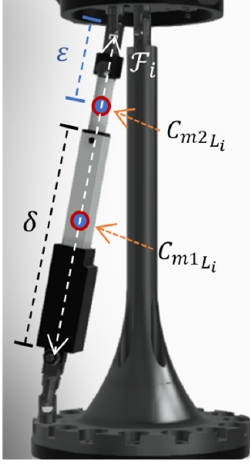
Figure 4. View of an actuated limb and the fourth restrictive limb inside the parallel mechanism; position of centers of mass and force applied to the actuator’s line of action are displayed. to which center of mass 𝐶 (cid:3040)(cid:2869)(cid:3013)(cid:3036) is placed at the middle. Moreover, 𝜀 determines the total distance between the attaching point 𝐵 (cid:3036) and the center of mass 𝐶 (cid:3040)(cid:2870)(cid:3013)(cid:3036) from the moving piston inside the linear actuator. ℱ (cid:3036) represents the force applied to the actuator and re ‐ quired to generate motion. Hence, the position of each center of mass (cid:4666) 𝑃 , in ‐